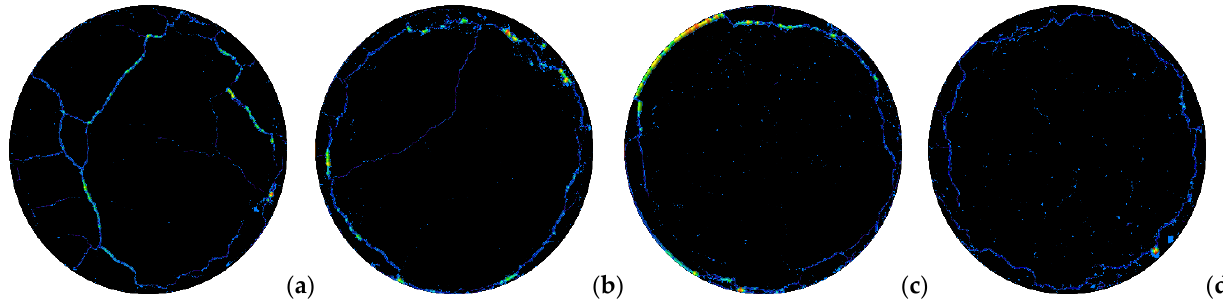
Figure 18. The dry density of 1.5 g/cm 3 : ( a ) 0.25 mm; ( b ) 0.50 mm; ( c ) 2.00 mm; ( d ) 5.00 mm.